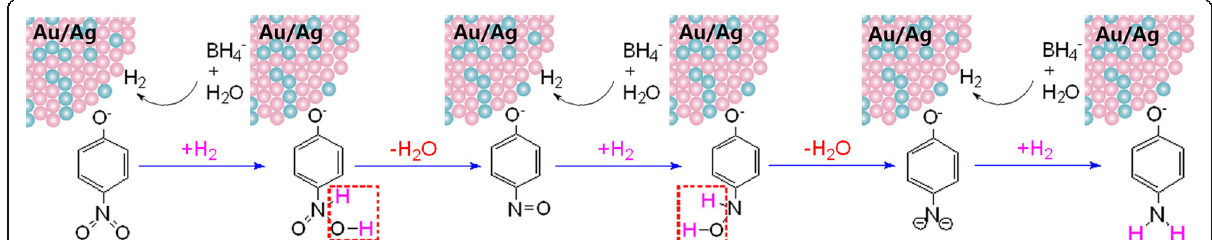
Fig. 9 The catalytic mechanism proposed for Nip reduction to Amp by NaBH 4 on the surface of Ag/Au